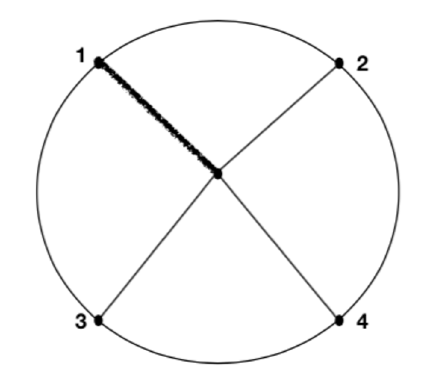
Figure 2 . AdS contact diagram for h j s j ˜0 j ˜0 j ˜0 i